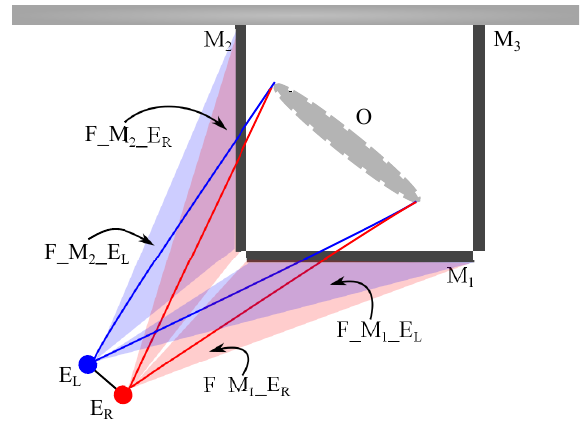
Sketch of generalized asymmetric frustums. The position E L and E R of the user’s eyes, which are in the same location of the virtual stereo cameras, are shown. The stereoscopic projections of the virtual object O are highlighted by the red and blue solid lines. The left and right generalized asymmetric frustums for the two monitors ( F M 1 E R and F M 1 E L for the M 1 monitor, and F M 2 E R and F M 2 E L for the M 2 monitor) are computed and generated at the same